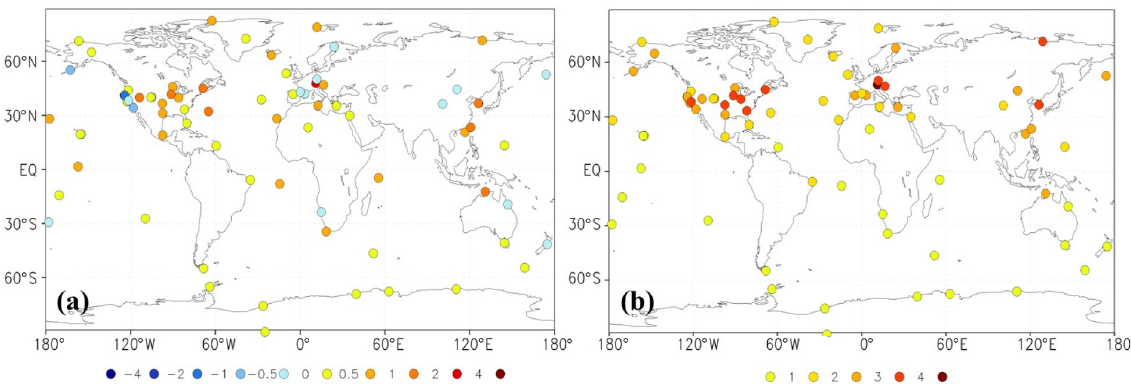
Figure 9. Spatial distributions of the (a) BIAS and (b) MAE of the posterior CO 2 concentrations at each site (simulations minus observations; unit: